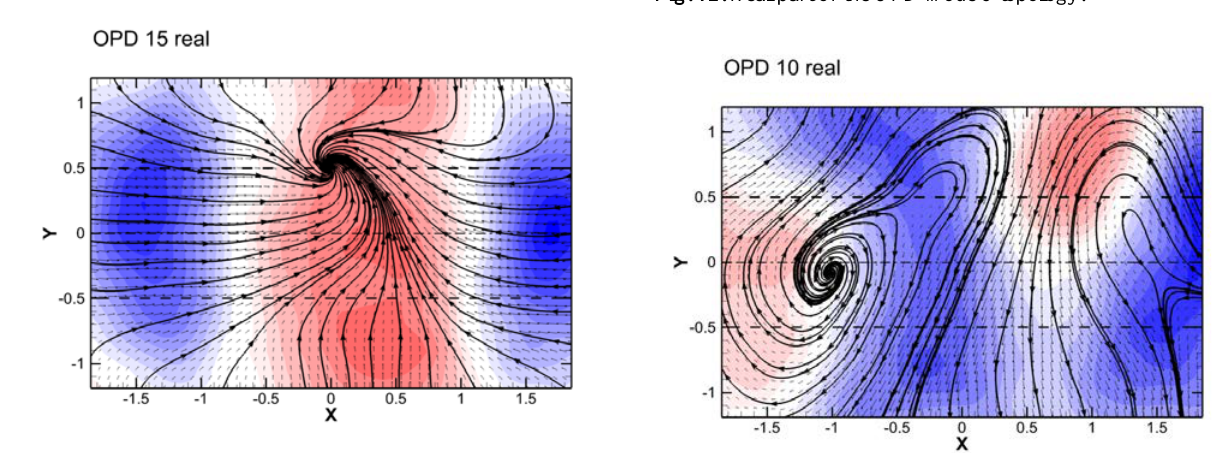
Fig. 13. Real part of the OPD mode 10 topology .